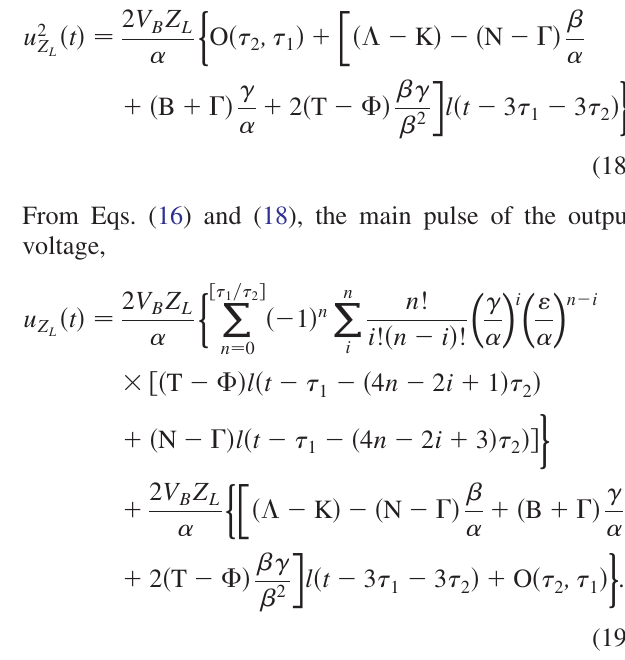
¼ 6 (cid:6) , Z ¼ 8 (cid:6) , Z ¼ 9 (cid:6) 1 3 L